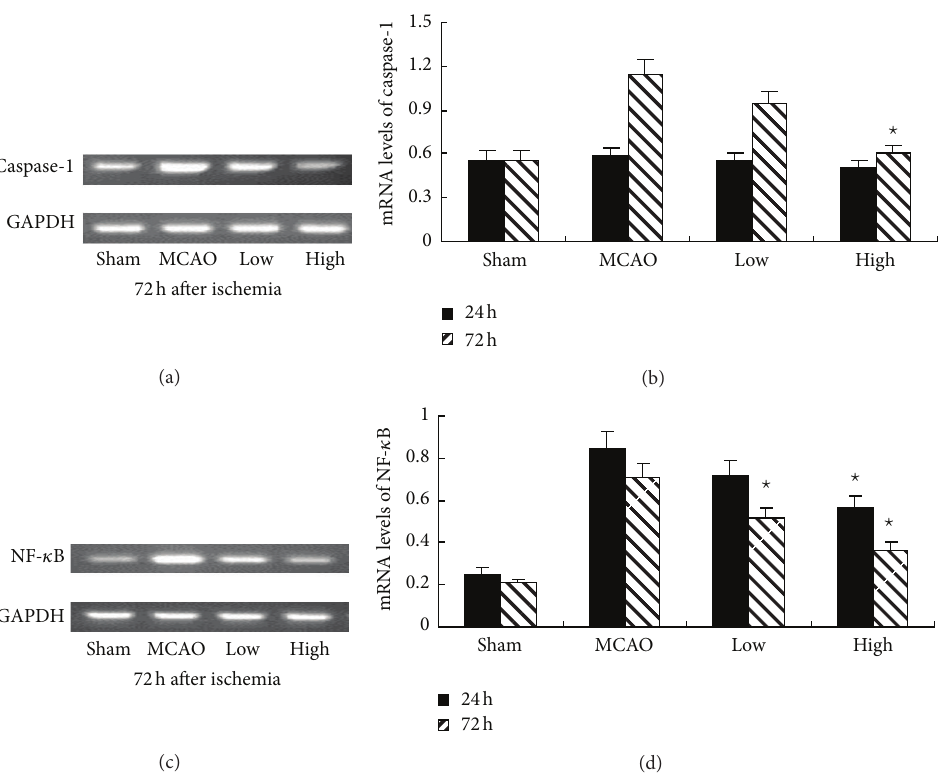
Figure 5: PN decreased mRNA expressions of caspase-1 and NF- 𝜅 B after MCAO. (b) shows the mRNA expression of caspase-1. Compared with MCAO group, the expression of caspase-1 was significantly decreased in High group 72 h. There is no difference between sham and MCAO group at 24h. (d) shows the mRNA expression of NF- 𝜅 B. Compared with MCAO group, the expression of NF- 𝜅 B was significantly decreased in High group both at 24 h and 72h, but decreased only at 72h in Low group ⋆ 𝑃 < 0.05 versus MCAO group. Representative photographs in ((a) and (c)) show the influence of PN on the mRNA expression of NF- 𝜅 B and caspase-1 at 72 h.